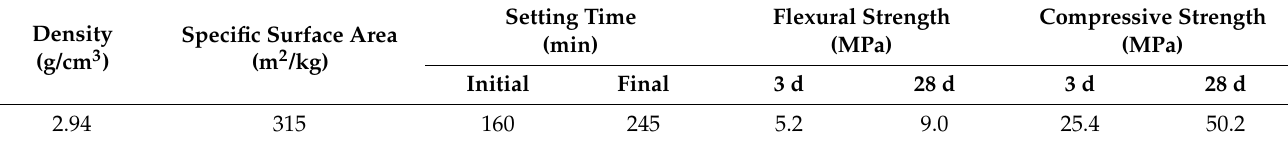
Table 2. Main physical properties of